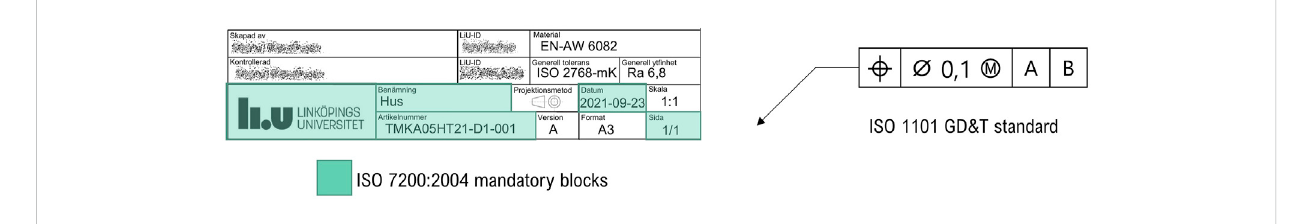
FIGURE 1 To the left, a typical Information block, it includes standard mandatory information and supplementary information. To the right, a typical feature control frame, FCF, following ISO 1101 GD&T